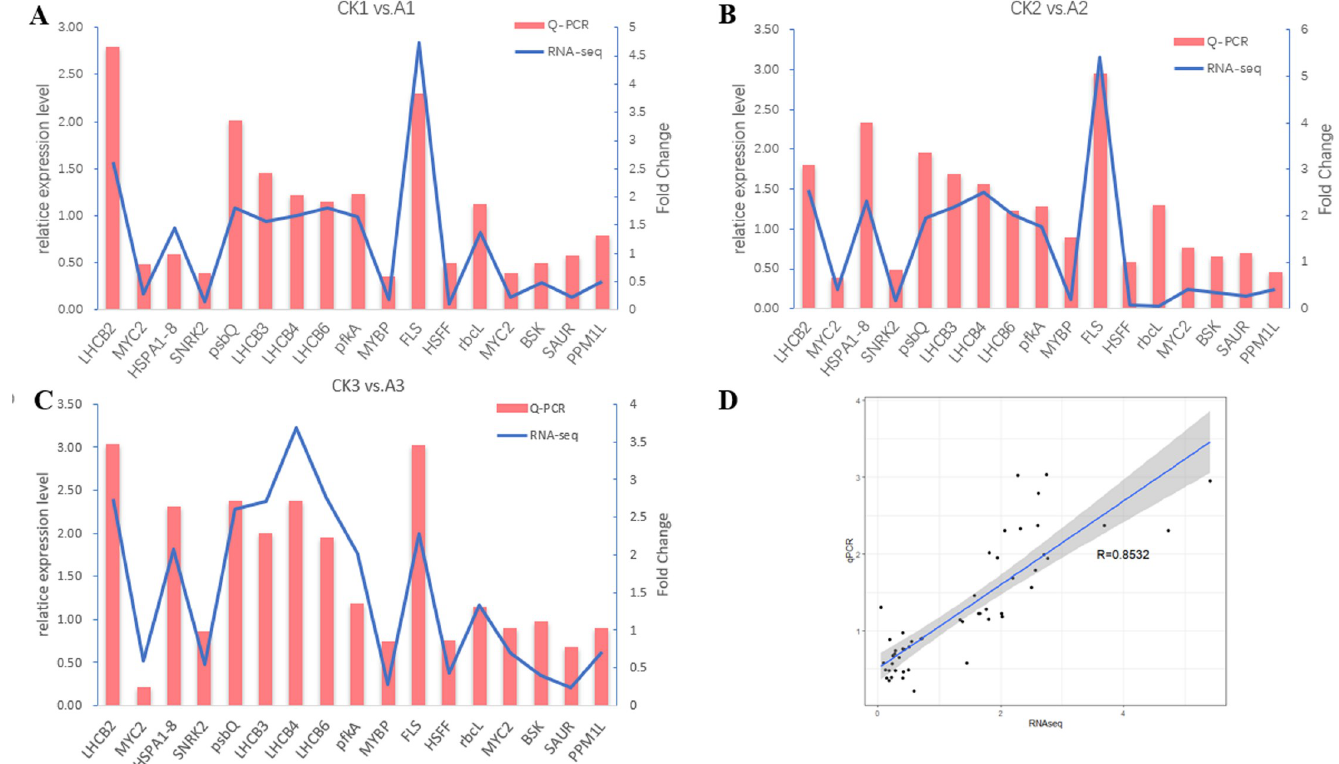
Fig 5. qRT-PCR analysis of differentially expressed genes. (A), (B), (C) represent the expression level of transcriptome sequencing and QRT PCR of 17 randomly selected genes in A1 vs. CK1, A2 vs. CK2 and A3 vs. CK3. The relative gene expression levels analyzed by QPCR were showed as Red histogram. The corresponding expression data of RNA-seq were showed as blue line. The x-axis represents the 17 randomly selected genes. Bars represent SE (n = 3). (D) Comparison between the log2 of the gene expression ratios obtained from RNA-seq data and qRT-PCR results.